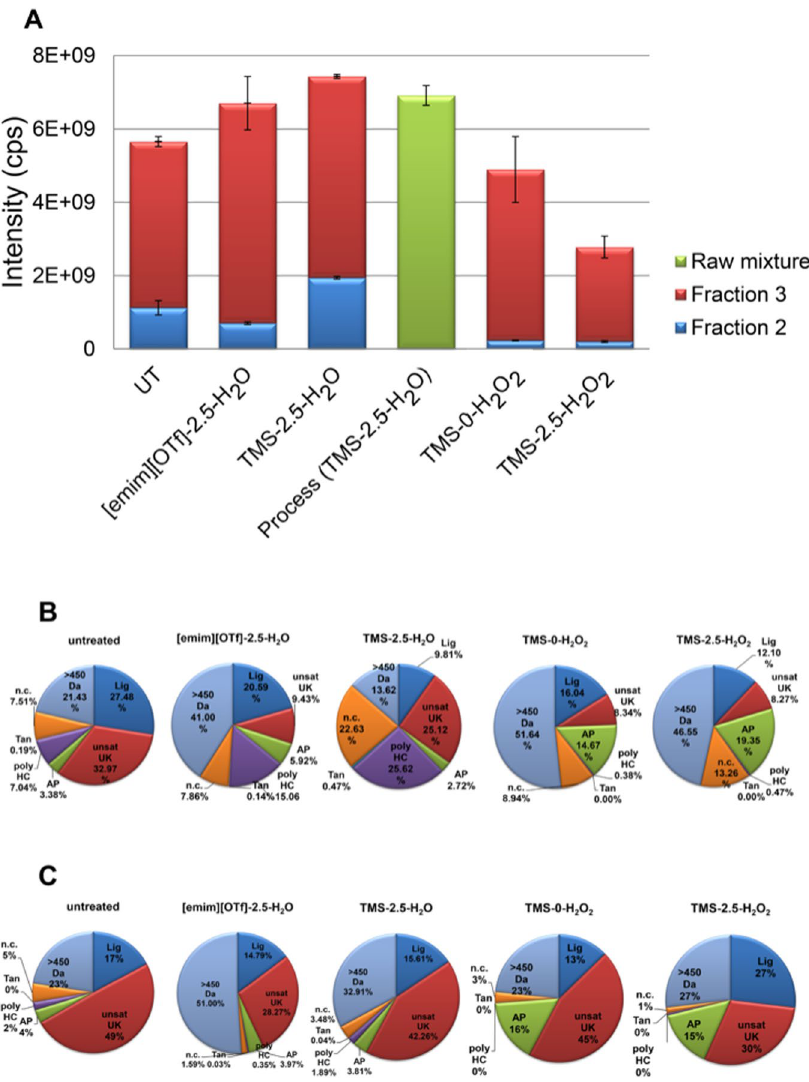
Figure 4. ( A ) Total intensities for relevant lignin degradation products. (mass concentration, β = 100 μ g/ mL) ( B ) Percent distributions of chemical classes for fraction 2. ( C ) Percent distributions of classes for fraction 3. Distributions were restricted to m/z ≤ 450, unless otherwise specified. Alkali lignin was used for all